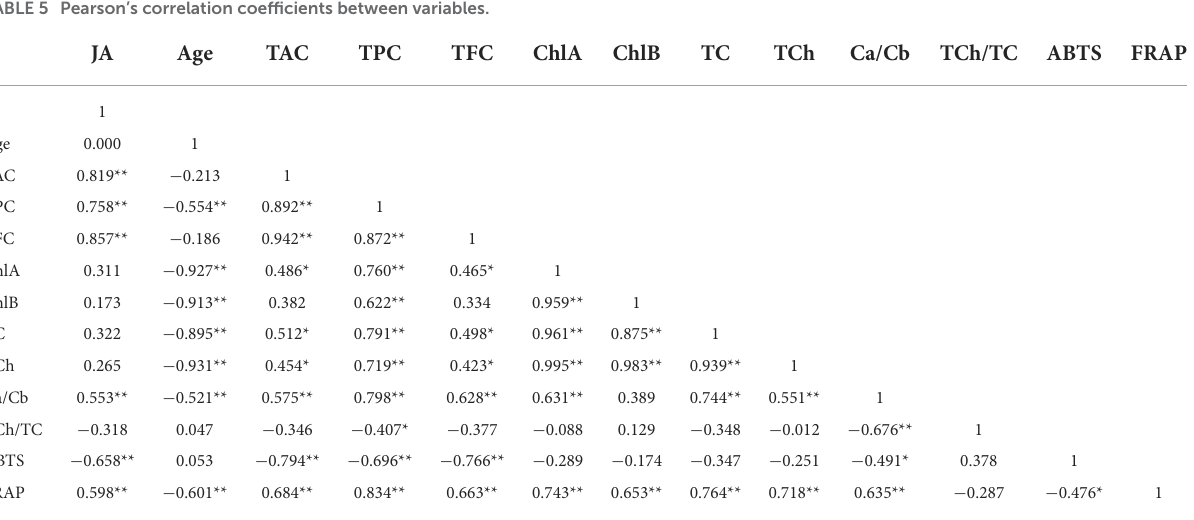
TABLE 5 Pearson’s correlation coefficients between